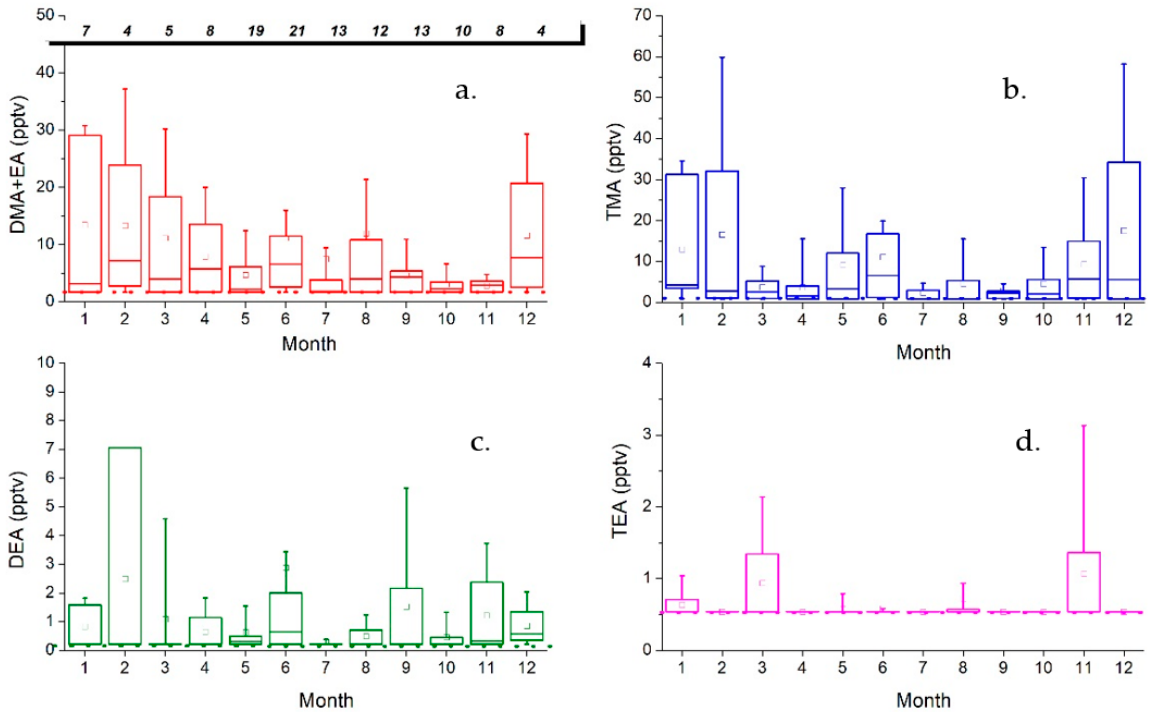
Figure 2. Seasonal average variation in concentrations (in pptv) of ( a ) DMA+EA, ( b ) TMA, ( c ) DEA, and ( d ) TEA at Finokalia station over the period 2013–2016. Whiskers represent 5th and 95th percentiles, box edges are 25th and 75th percentiles, the line in the box is the median, and the open square is the mean.